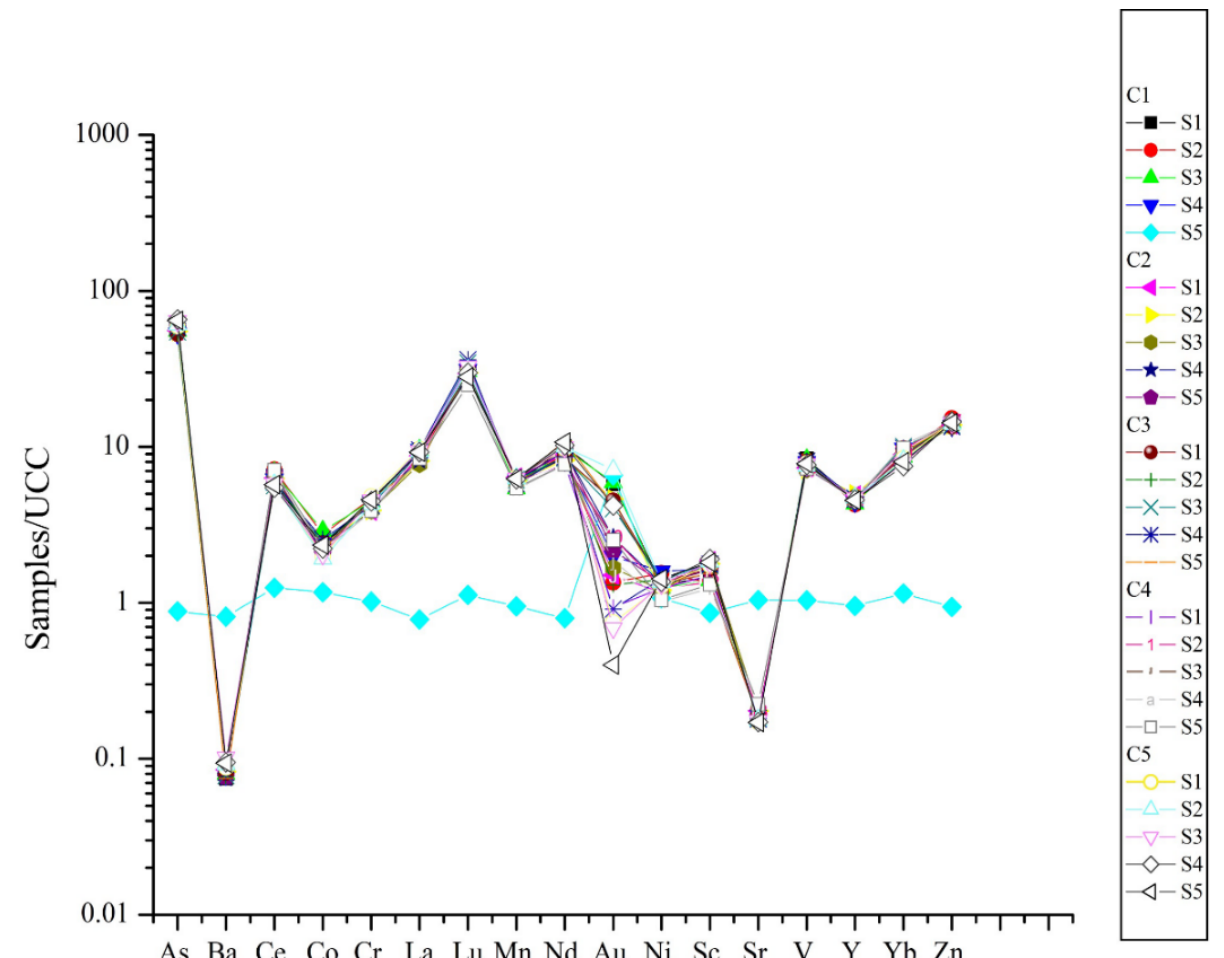
Figure 7. Trace element diagram for the sediments of the Indus River. After UCC standard [41], a graph shows the high values of Au, As, Lu, Sc, Yb, Z in the samples. Sample C1-S5 indicates high gold concentration and low concentration of other elements, which may be due to the hydrothermal quartz vein that contains gold.